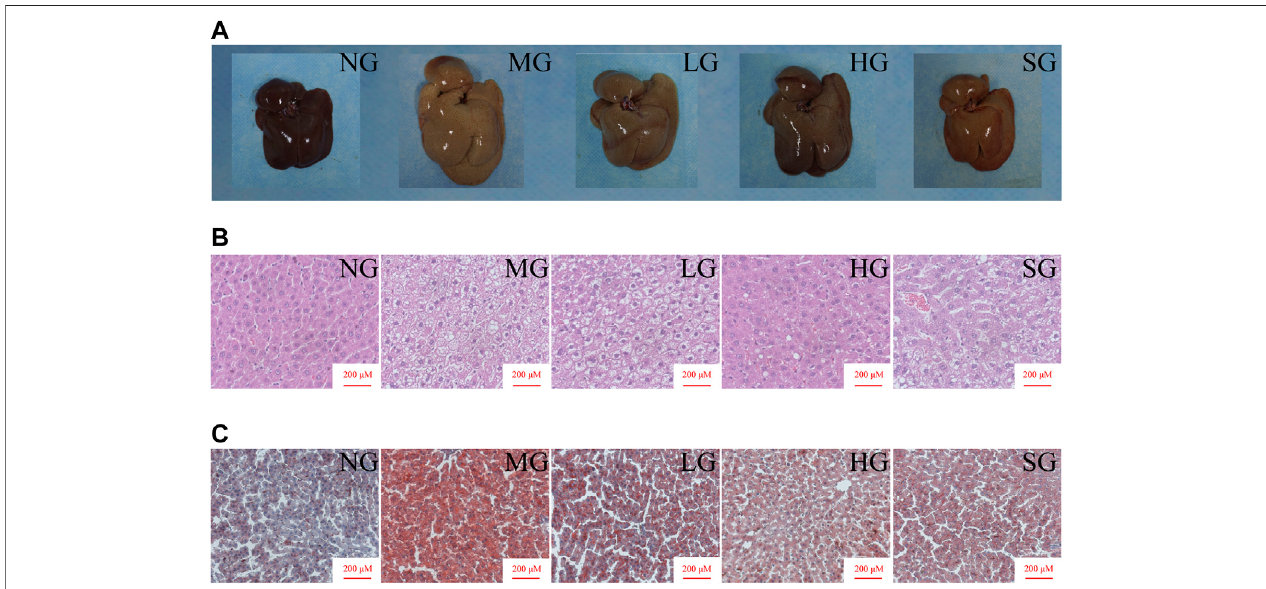
FIGURE2| ImpactsofdiosgeninonliversfromSDrats (A) macroscopicpicturesoflivers; (B) representativeliversectionsstainedwithH&E; (C) representativeliver sections stained with oil red.